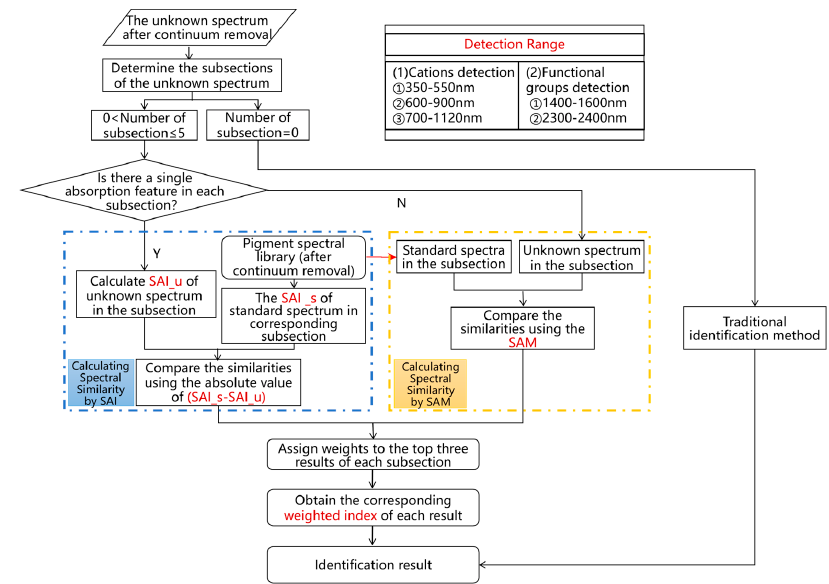
Figure 2. The spectral subsection identification method (SAI, Spectral Absorption Index; SAM, Spectral Angle Mapping).